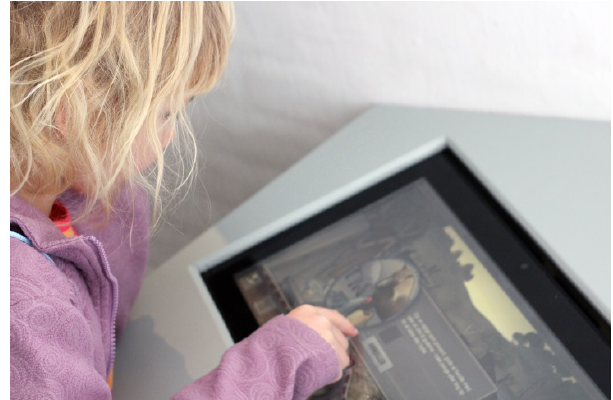
Figure 13. Playing a touch screen based game in the exhibition room. Museet Ribes Vikinger, Denmark.